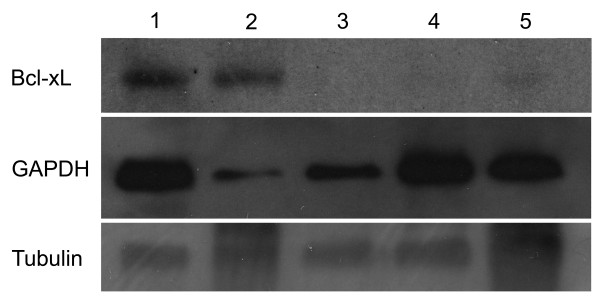
Western blot analysis of Bcl-xL expression in human normal and tumoral liver. Lane 1: hepatocellular carcinoma (male, age 65); lane 2: adenocarcinoma (male, age 52); lane 3: cholangiocellular carcinoma (male, age 46); lane 4: normal liver (male, age 24); lane 5: normal placenta (female, age 24). Bcl-xL immunoreactivity (26 kD) was observed in two out of three liver cancer samples (lanes 1–3). Normal samples (lane 4–5) had no signal for Bcl-xL expression. Note that GADPH protein levels varied between normal tissues and cancer liver specimens and did not correlate with the mRNA levels predicted by the computer-based screen. The expression of tubulin was used as control for equal protein loading.